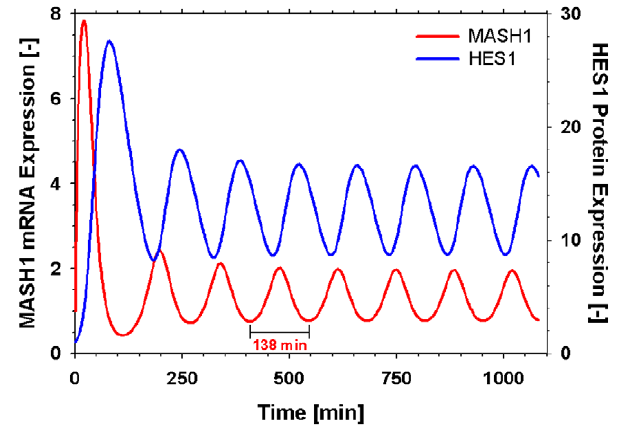
Figure 2. Oscillatory expression of Mash1 at steady state for non-differentiated cells using the parameter values from Table 1. Oscillatory behaviour of the pathway with a period of roughly 2.5 h. Mash1 concentration peaks between the concentration peaks of its repressor Hes1.